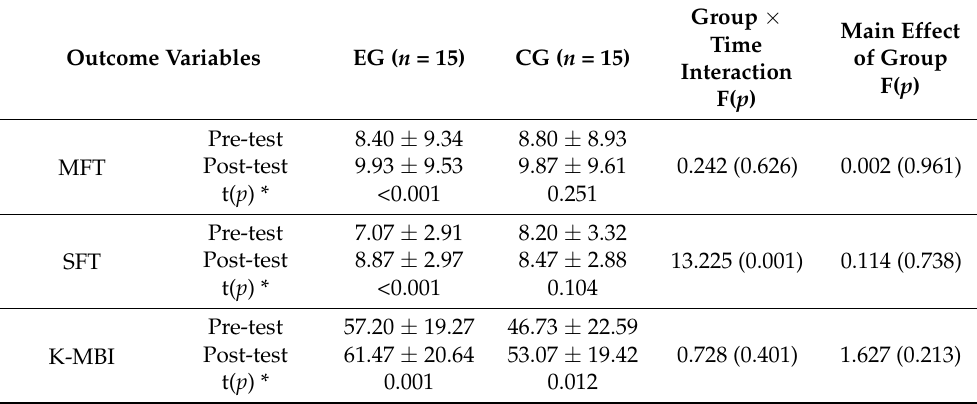
Table 2. Motor and sensory functions and daily activity before and after the interventions in the groups ( n =